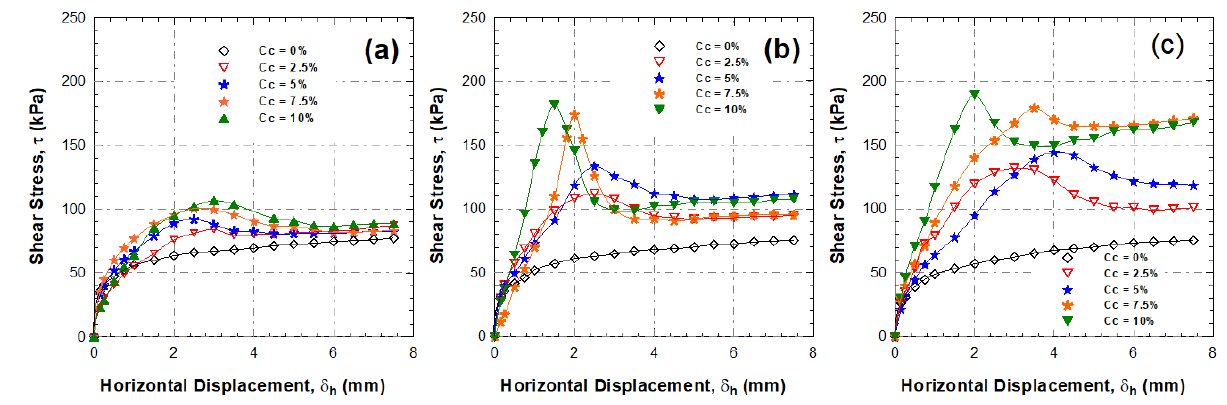
Figure 5: Cement content influence on the shear strength of cemented sand ( σn = 100 kPa), (a) ω = 3%, (b) ω = 7%, (c) ω = 10%.